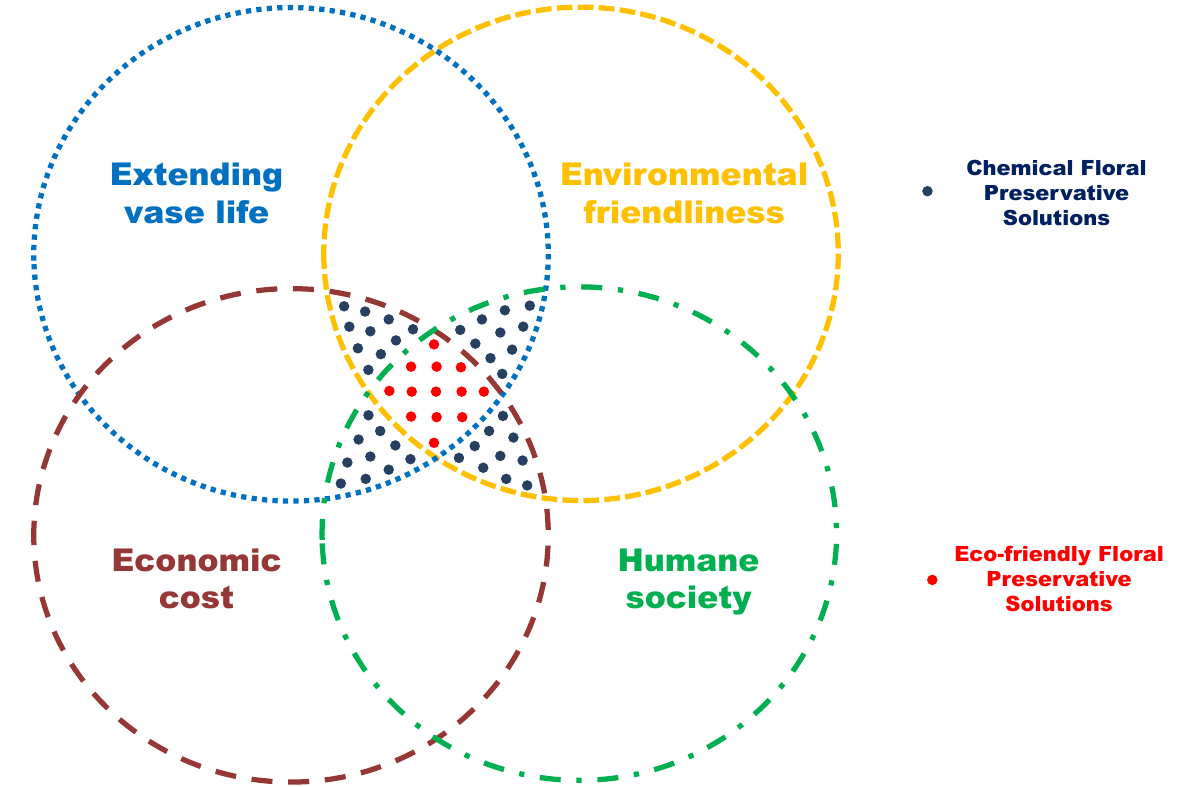
Figure 1. Dimensions of further development of floral preservative